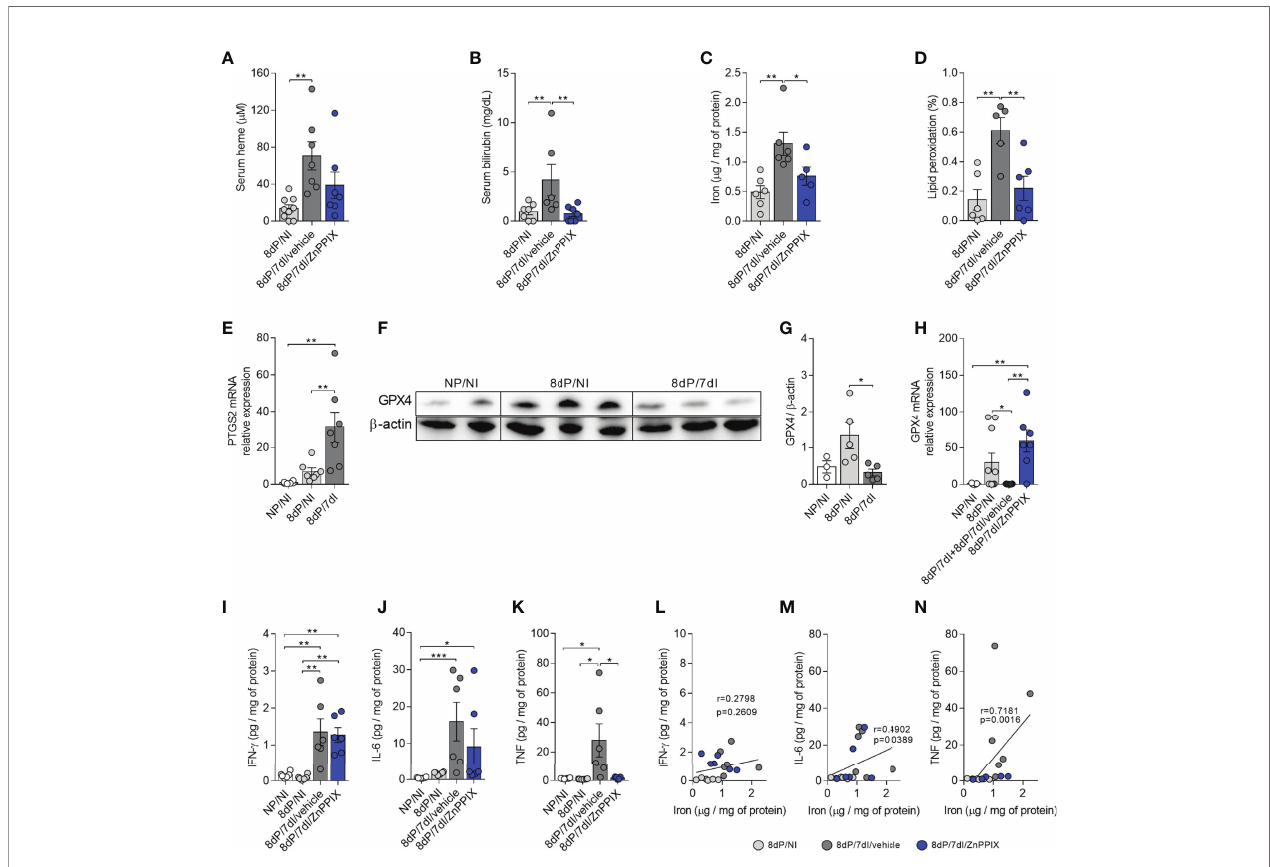
FIGURE 6 | Infection-induced in fl ammation and oxidative stress are prevented by HO-1 inhibitory treatment. (A, B) Serum levels of heme (8dP/NI, n=9; 8dP/7dI/ vehicle, n=7; 8dP/7dI/ZnPPIX, n=7) and bilirubin (8dP/NI, n=7; 8dP/7dI/vehicle, n=6; 8dP/7dI/ZnPPIX, n=7) were measured. (C, D) Iron (8dP/NI, n=6; 8dP/7dI/ vehicle, n=6; 8dP/7dI/ZnPPIX, n=5) and lipid peroxidation levels (8dP/NI, n=6; 8dP/7dI/vehicle, n=5; 8dP/7dI/ZnPPIX, n=6) were quanti fi ed in tissue samples from implantation sites. (E) mRNA expression of PTGS2 in uterus/placenta was measured by qPCR normalizing to GAPDH expression and using NP/NI group as calibrator (NG/NI, n=6; 8dP/NI, n=7; 8dP/7dI, n=7). (F, G) Protein extracts from uterine samples were subjected to western blot analysis to determine the relative expression of GPX4 and b -actin proteins (F) . Quantitative analysis of the densitometric analysis of bands (NG/NI, n=3; 8dP/NI, n=5; 8dP/7dI, n=5) (G)